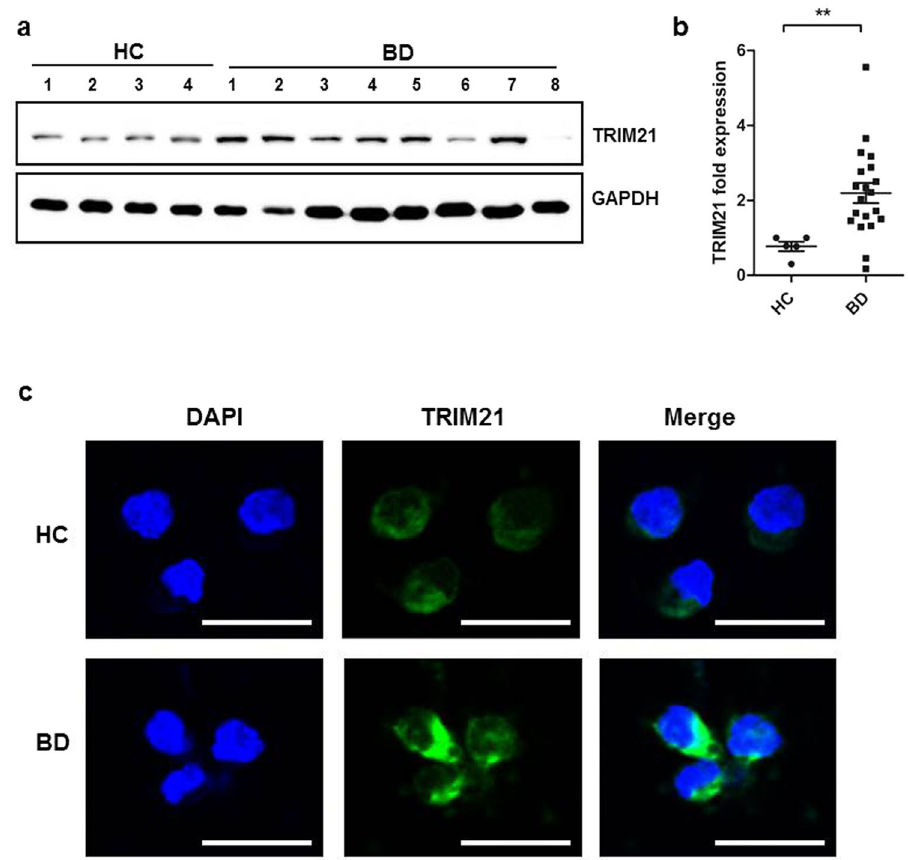
Figure 1. Monocytes from Behçet’s disease patients exhibited increased TRIM21 expression compared to those from healthy controls. ( a and b ) Human monocytes isolated from healthy volunteers and BD patients. TRIM21 protein levels in monocytes from 18 BD patients and five healthy control subjects, as determined by western blot ( a ). TRIM21 expression was quantified by densitometry following normalization to GAPDH expression as indicated in accompanying graph ( b ). Data are expressed as the mean ± SD. ** P < 0.01. The cropped blots are displayed and full-length blots are shown in the Supplementary Information. ( c ) Endogenous TRIM21 was visualized by immunofluorescence using anti-TRIM21 (green) and DAPI (blue) and observed under confocal microscopy. Scale bar represents 20 μ